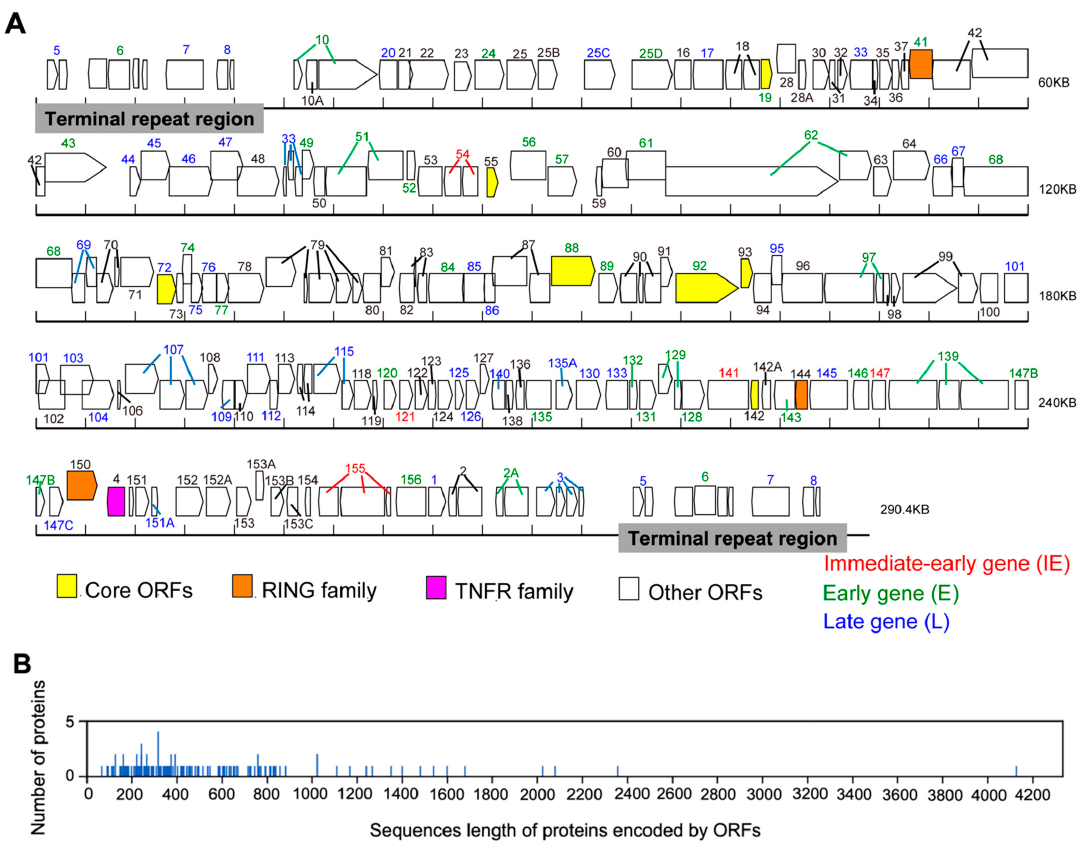
Figure 1. Genome map of CyHV-2 SH-01 and sequence lengths of proteins encoded by open reading frames (ORFs). ( A ) The SH-01 genome is 290,428 bp in length and contains 154 potential ORFs. Arrows indicate the size, location, and orientation of the 154 ORFs, with nomenclature lacking the ORF prefix given below. The number of arrows in an ORF indicates the number of exon-formed coding sequences (CDS) it contains due to the presence of introns. Two terminal repeat (TR) regions are marked with grey boxes. Seven core ORFs are indicated by yellow arrows (Core ORFs). Three ORFs with a RING-finger domain are indicated by orange arrows (RING family). One ORF belonging to the TNFR family is indicated by a pink arrow (TNFR family). The 143 unclassified ORFs are indicated by white arrows (Other ORFs). Five immediate-early (IE), 34 early (E), and 39 late (L) genes are marked in red, green, and blue, respectively, and unidentified genes are marked in black. ( B ) The graph of the sequence lengths of the proteins encoded by 154 ORFs (X-axis) vs. the number of proteins per length was calculated by Geneious Prime v2022.2.1